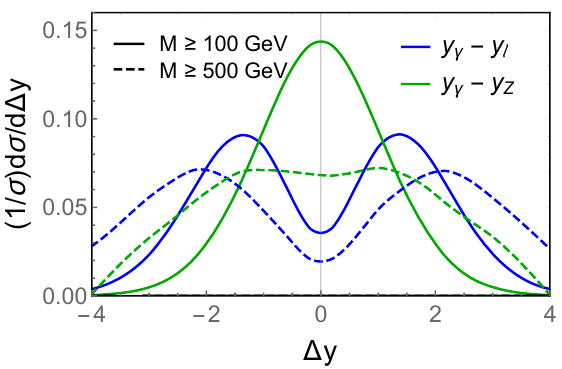
Figure 4 . Comparing di(cid:11)erence in rapidities distributions from W ( ‘ + (cid:23) ) (cid:13) and Z ( ‘ + ‘ tion (SM background at LO). Solid lines include the basic cuts in eqs. (2.2), (2.4), while dashed lines include an extra cut in the transverse (invariant) mass m ‘(cid:23)(cid:13) the letter M